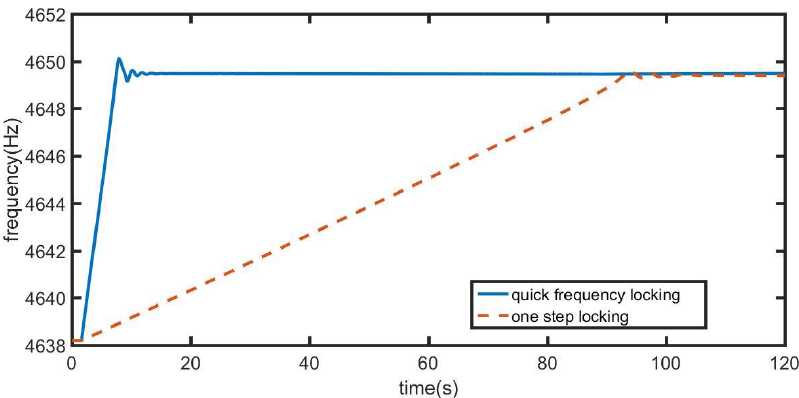
Figure 17. Comparison of two control modes when the initial frequency deviation is 10Hz.